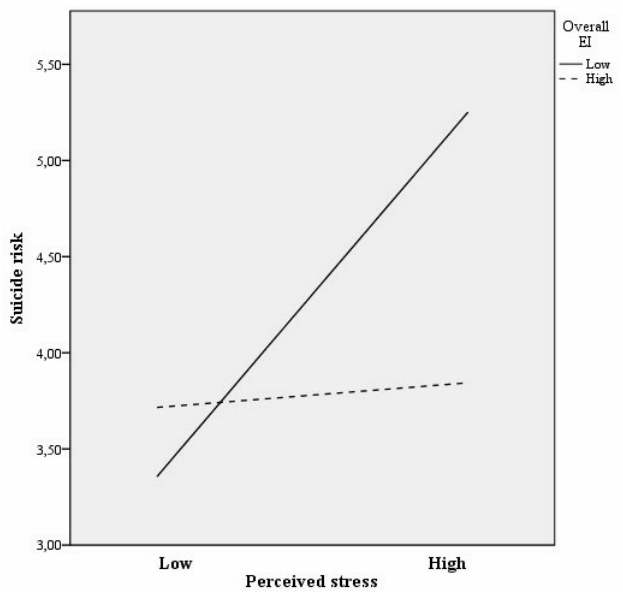
Figure 3. Interaction between EI and perceived stress with regard to suicide risk in the long-term unemployed